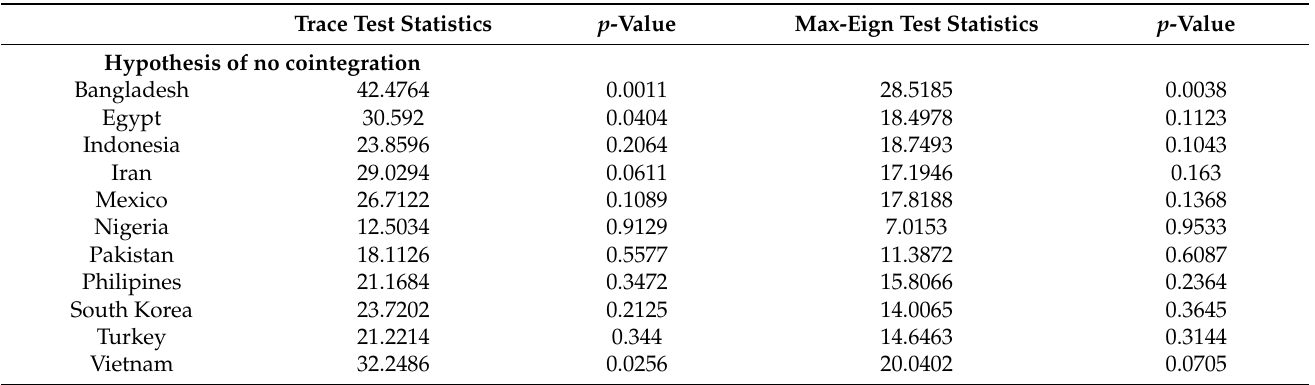
Table 4. Linear cointegration